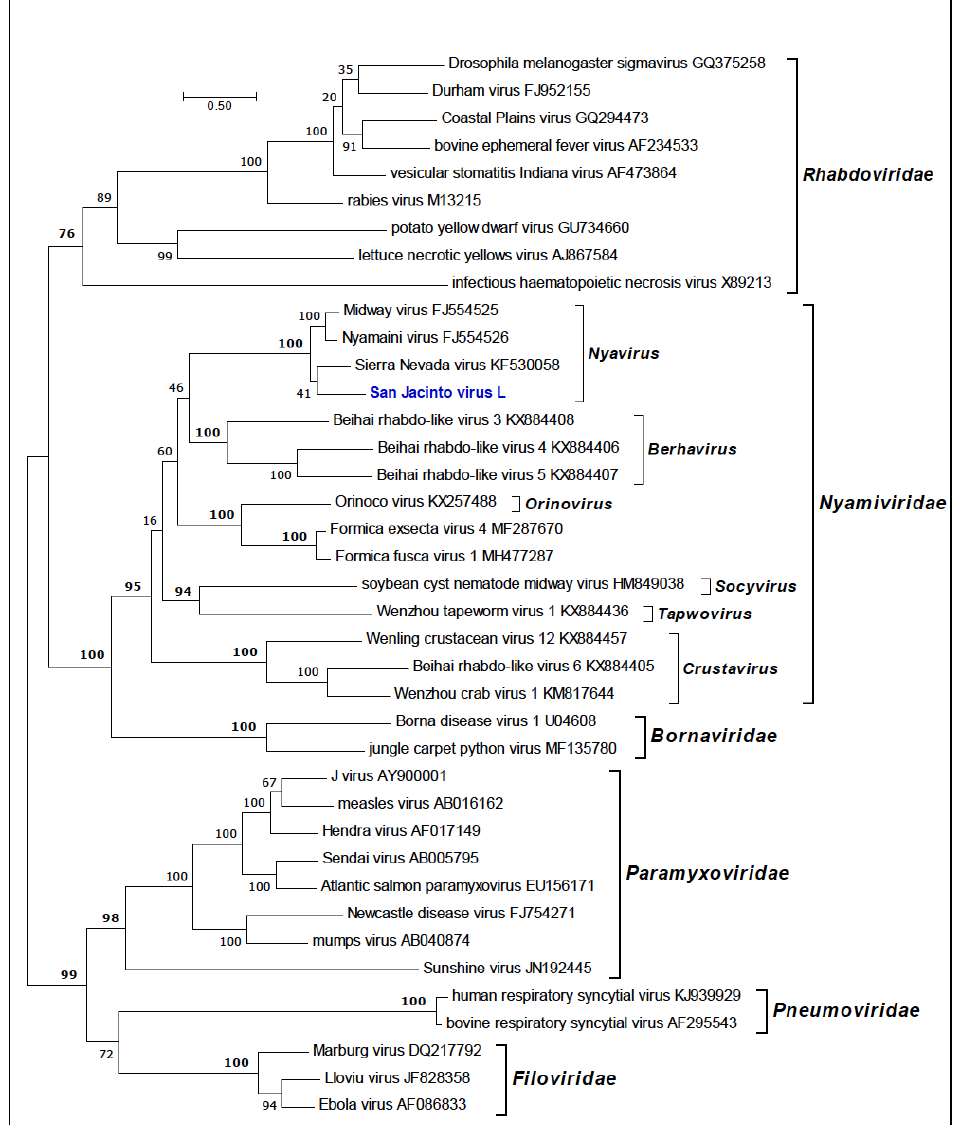
Figure 3. Maximum likelihood phylogenetic tree of the RNA-dependent RNA polymerase (L protein) amino acid sequences for representative members of the order Mononegavirales with emphasis on the family Nyamiviridae . Branch lengths are proportional to the number of nucleotide substitutions per site. Values for bootstrap support proportion (BSP) were determined from 100 bootstrap iterations. BSP values showing strong support for each of the key nodes are shown in bold. The position in the tree of SJCV is shown in blue. The Genbank accession numbers of all sequences are as shown.